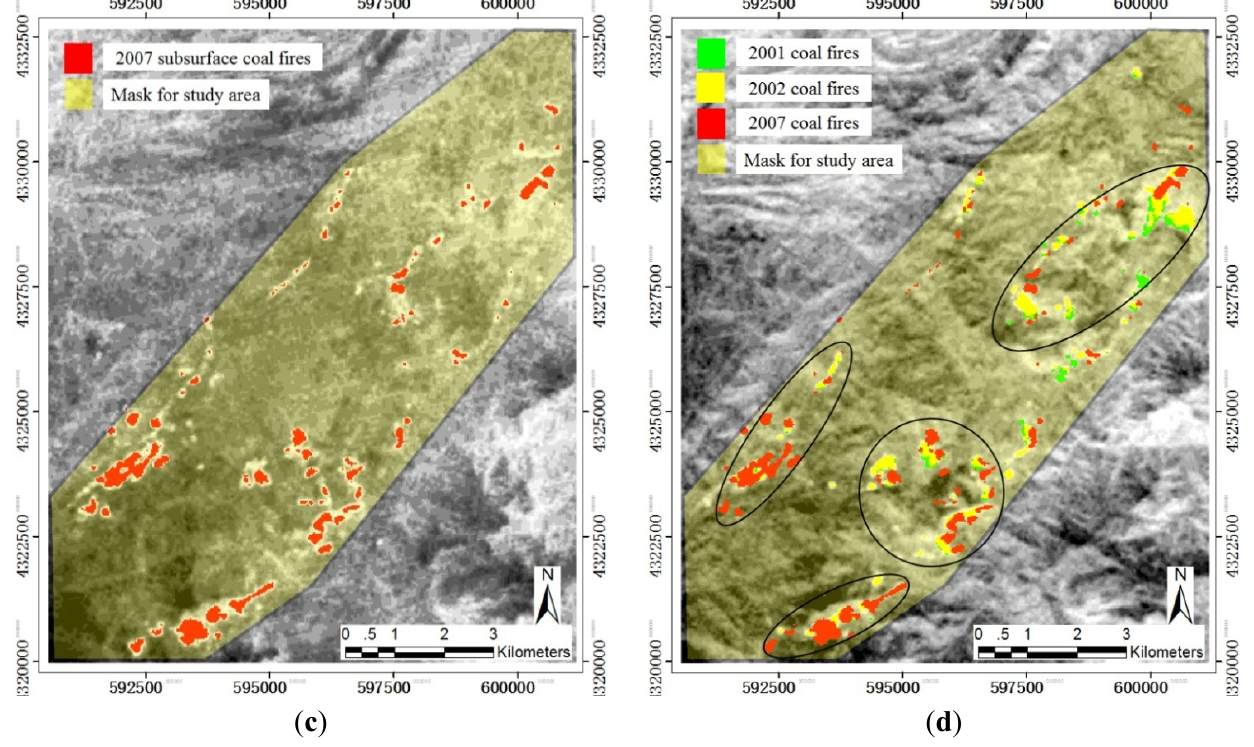
Figure 6. Surface coal fires extracted from the ETM+ SWIR band 7 data of 2001, 2002, and 2007. ( a ) surface coal fires of 2001; ( b ) surface coal fires of 2002; ( c ) surface coal fires of 2007; ( d ) multi-layer surface coal fires of 2001, 2002, and